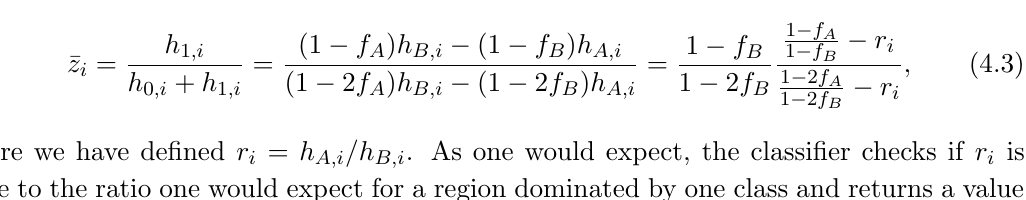
Figure 8 . The e(cid:11)ect of a cut on a deformed classi(cid:12)er (cid:22) z 0 (cid:22) z i . As long as the mapping between the two is monotonic, a single cut on (cid:22) z 0 to some cut on the optimal classi(cid:12)er. As soon as monotonicity breaks down, some cuts on (cid:22) z 0 be contaminated by less signal-pure regions of feature